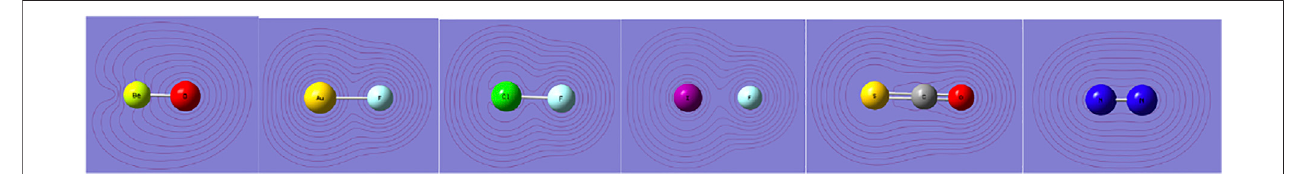
FIGURE 2 | Density (0.001 au), electrostatic potential mapped on the density surface (blue for positive and red for negative), and electrostatic potential contours (yellow for positive; red for negative). From (A – C) : polar molecule (AuF), nonpolar molecule with positive quadrupole (Cl 2 ), and with negative quadrupole (N 2 ).